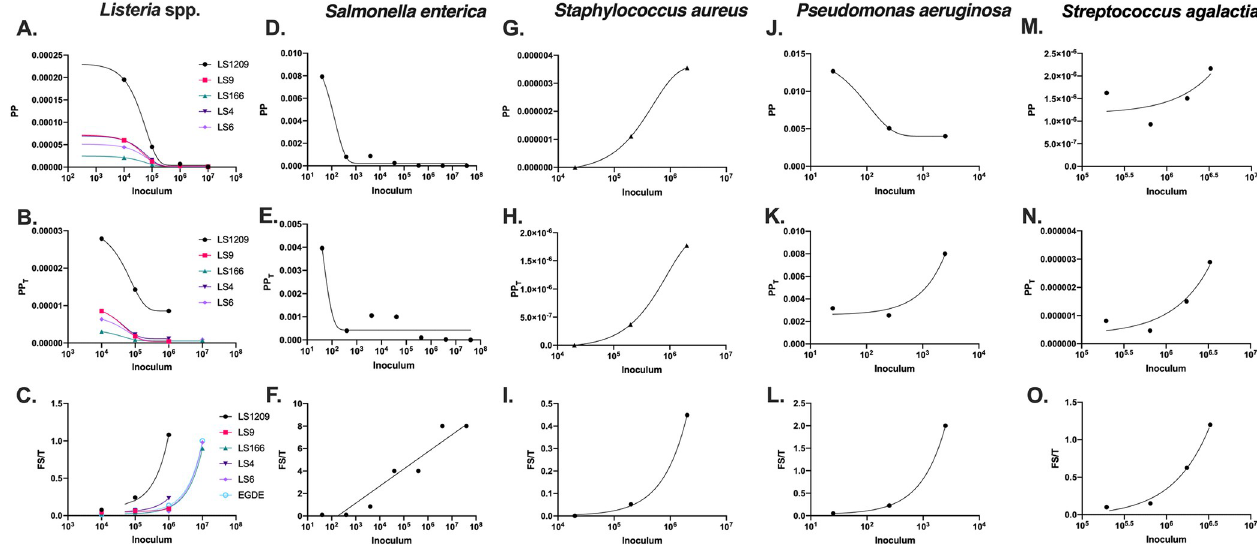
Fig 6. Pathogenic potentials of bacterial species in G. mellonella hosts . Using literature values [22–27] we calculated the Pathogenic Potential (PP), Pathogenic Potential in regards to time (PP T ), and Fs/T for (A-C) Listeria spp ., (D-F) Salmonella enterica , ( G-I) Staphylococcus aureus , (J-L) Pseudomonas aeruginosa , and (M-O) Group B Streptococcus . Overall, we found various relationships between the measures of pathogenic potential and the bacterial inoculum that varied species to species. While most of the (A, D, J) PP values had a negative exponential relationship with the inoculum and are best-fitted with an exponential decay function, S . aureus had positive exponential relationships between the (G) PP and (H) PP T versus inoculum, and (M,N) Streptococcus and (K) P . aeruginosa (PP T only) had positive linear relationships between the PP and PP T versus inoculum, best-fitted with a simple linear regression. All the bacterial species investigated besides (F) Salmonella enterica had a linear Fs/T vs. I relationship, which is inconsistent with what is seen in fungi. The linear relationship indicates each bacterium influences the degree and speed of death, rather than the order of magnitude of bacteria.